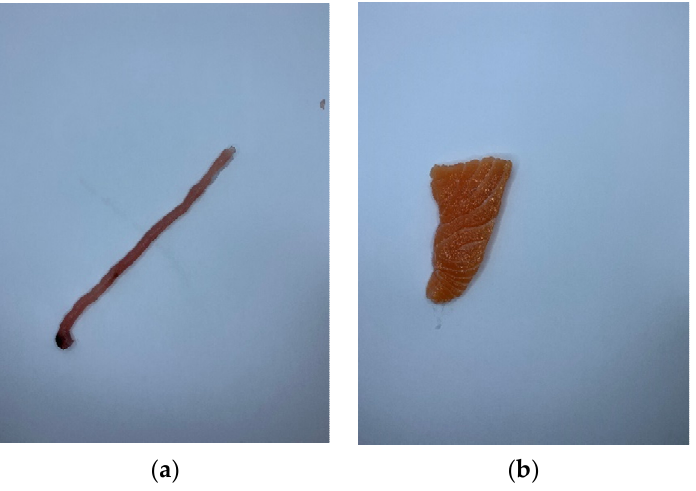
Figure 1. ( a ) Tuna and ( b ) salmon meat samples extracted from fresh fish, to be photographed.